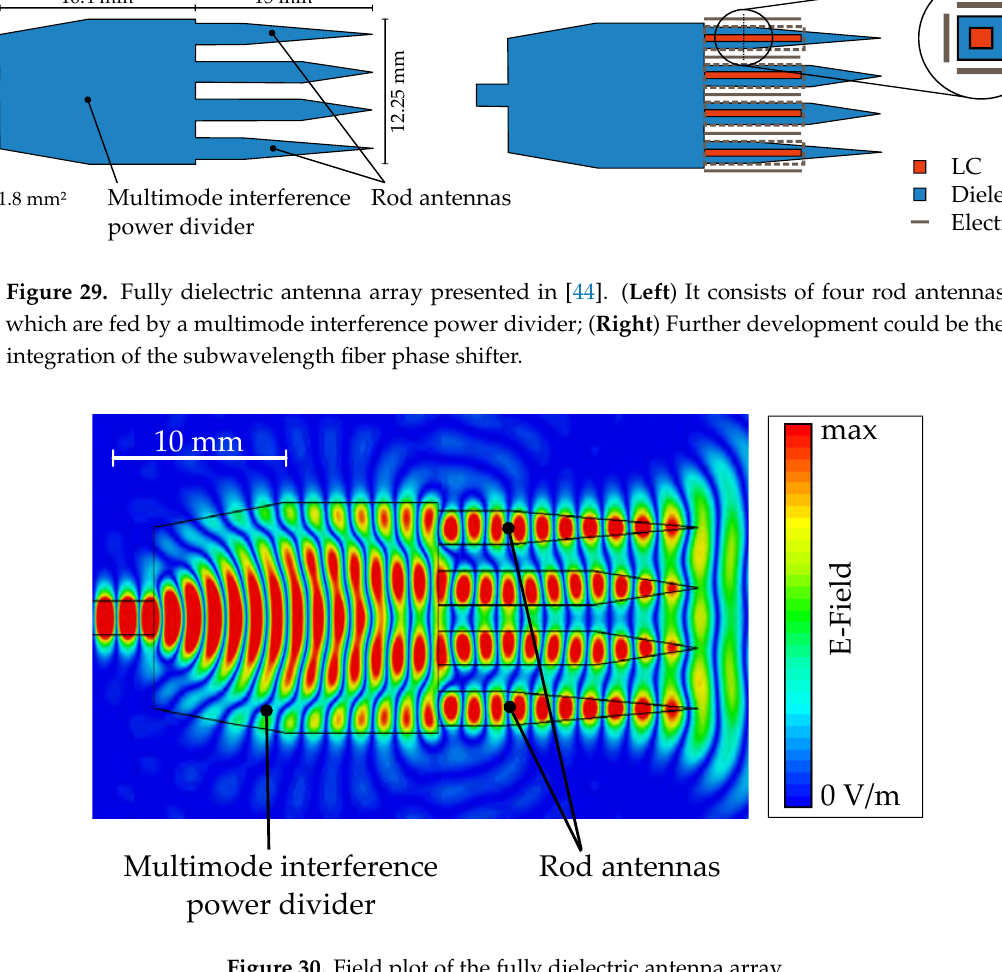
Figure 30. Field plot of the fully dielectric antenna array. Table 3. Comparison of different phase shifter technologies at W-band.